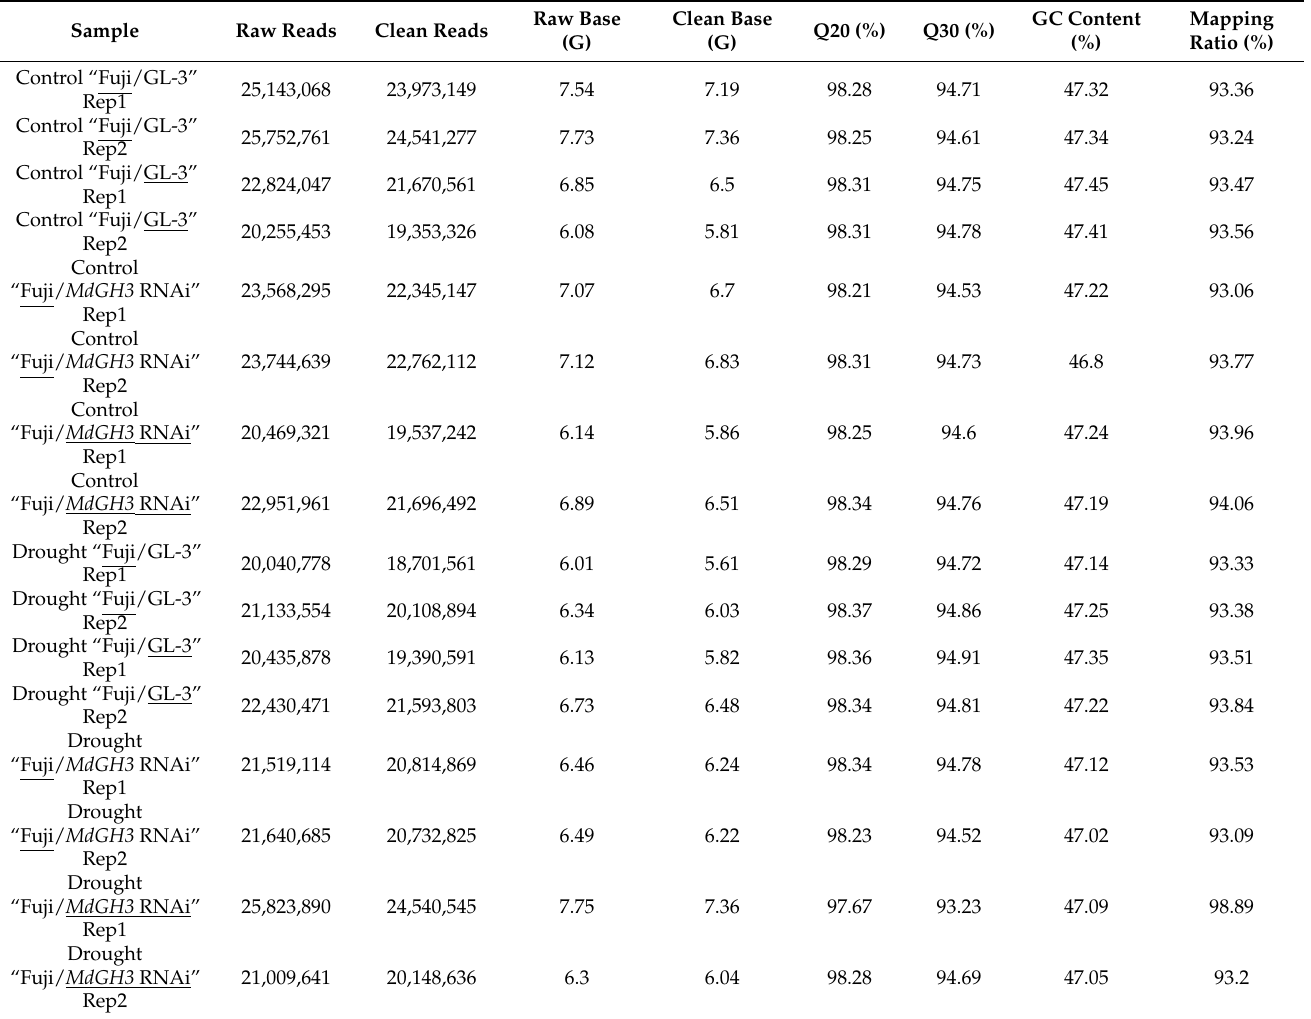
Table 1. The Statistics of transcriptome sequencing (RNA-seq)